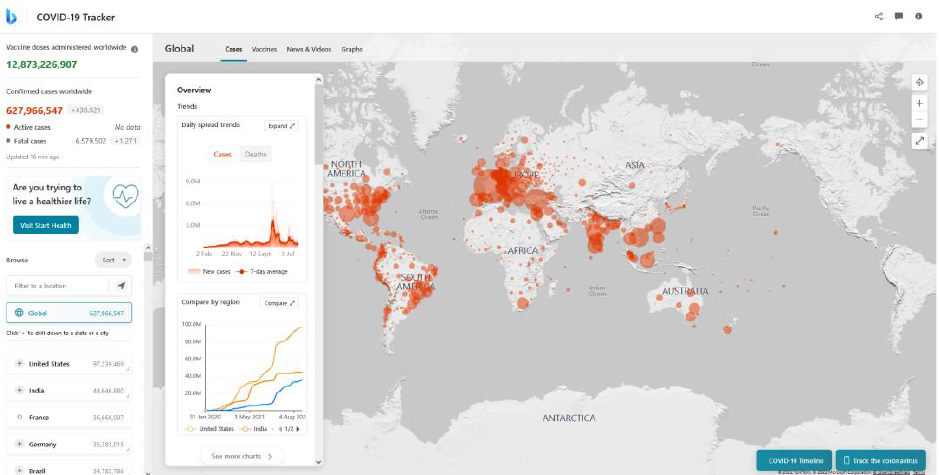
Figure 10. Microsoft Bing’s COVID -19 Tracker , note(s): Screenshot of Bing’s COVID -19 Tracker, 9 February 2022.